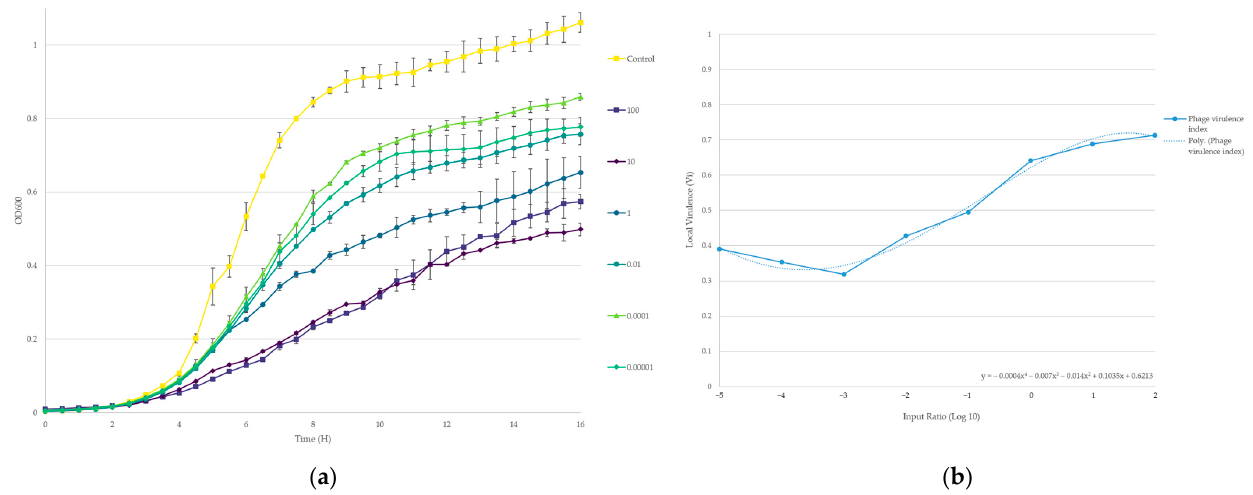
Figure 2. Determination of 4HA13 virulence against E. coli O111:NM in TSB, 25 °C. ( a ) Growth of E. coli O111:NM treated with 4HA13 at phage-to-host ratios of 10 − 5 to 10 2 over 16 h. The curves were normalized against an assay blank average; ( b ) local virulence (Vi) values, as determined using the calculations set out by Storms et al., were plotted against the input ratios [22]. A curve of best fit and its polynomial equation allowed for the determination of 4HA13’s virulence index (y = Vi = 0.5) and are indicated by the red dash line.